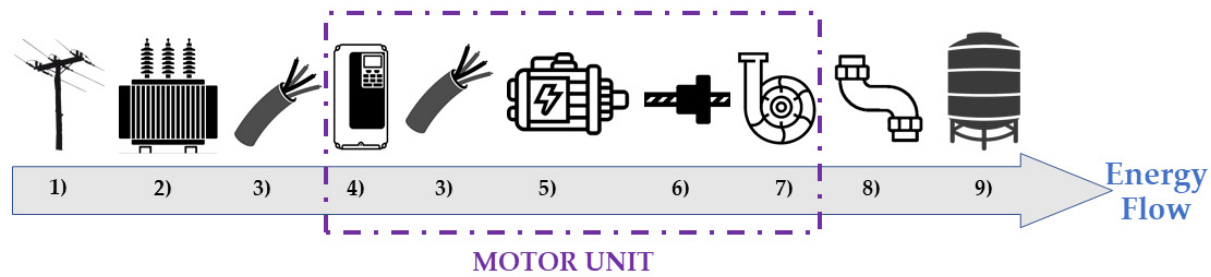
Figure 6. Pumping system using VSD. Source: Adapted from